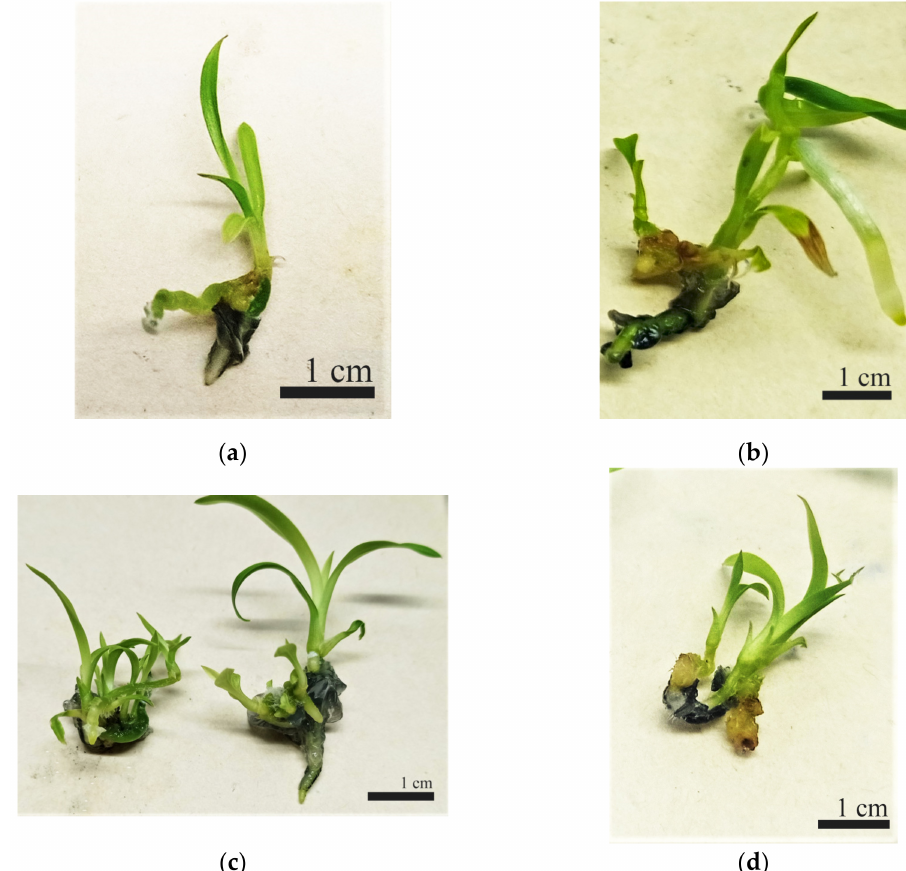
Figure 2. Influence of different concentrations of 6-BAP on the formation of new protosomes: